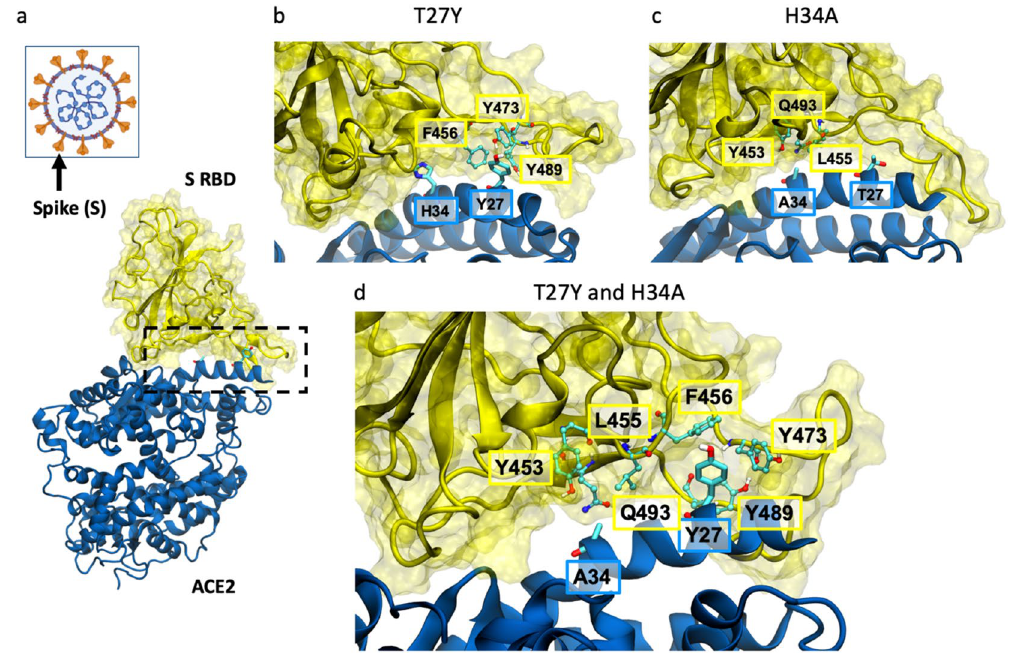
Figure 2. Molecular effects of T27Y and H34A ACE2 mutations predicted by MD simulation. ( a ) Spike (S) occurs as a trimer on the viral surface (orange projections), with the receptor binding domain (RBD) being on the outermost surface. The interface between S RBD and ACE2 is within the dashed box. Simulation models are shown for ( b ) ACE2(T27Y)-, ( c ) ACE2(H34A)-, and ( d ) ACE2(T27Y/H34A)-S RBD interactions. S RBD residues are labeled in the yellow boxes and ACE2 residues in blue